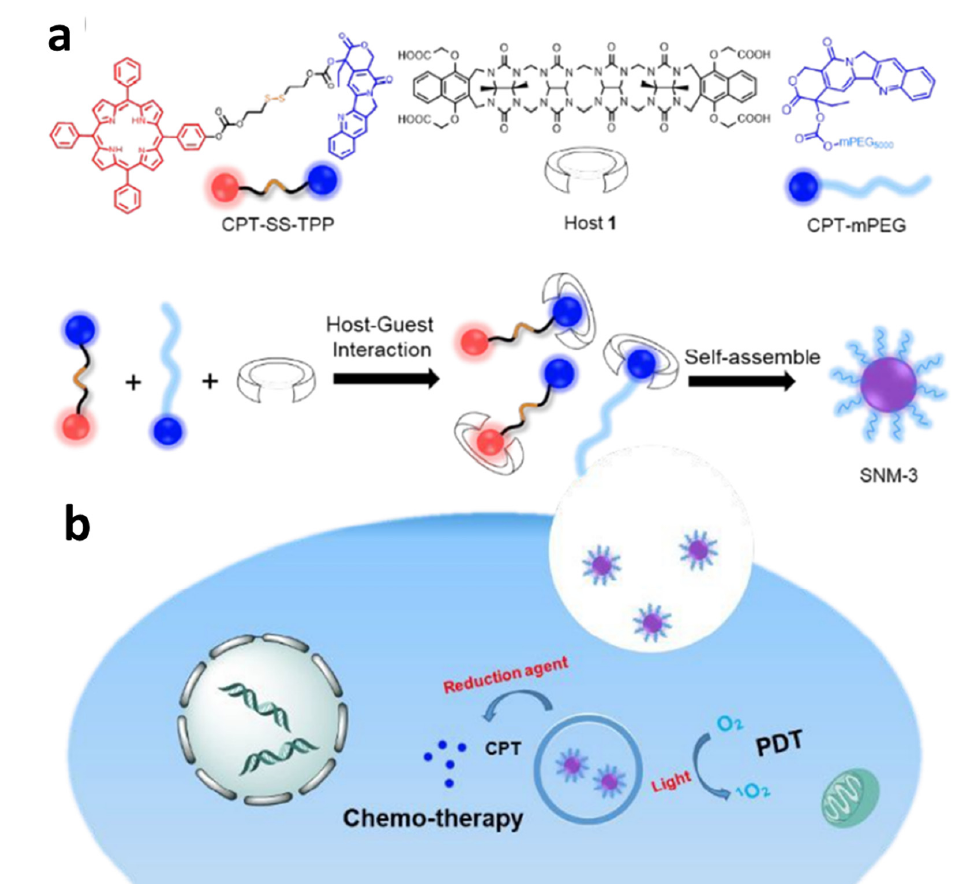
Figure 22. ( a ) Chemical structure and schematic diagram of CPT-SS-TPP, CPT-mPEG, and host 1; ( b ) Schematic diagram of chemophotodynamic combination therapeutic method (reproduced with permission of Royal Society of Chemistry from ref. [98]).